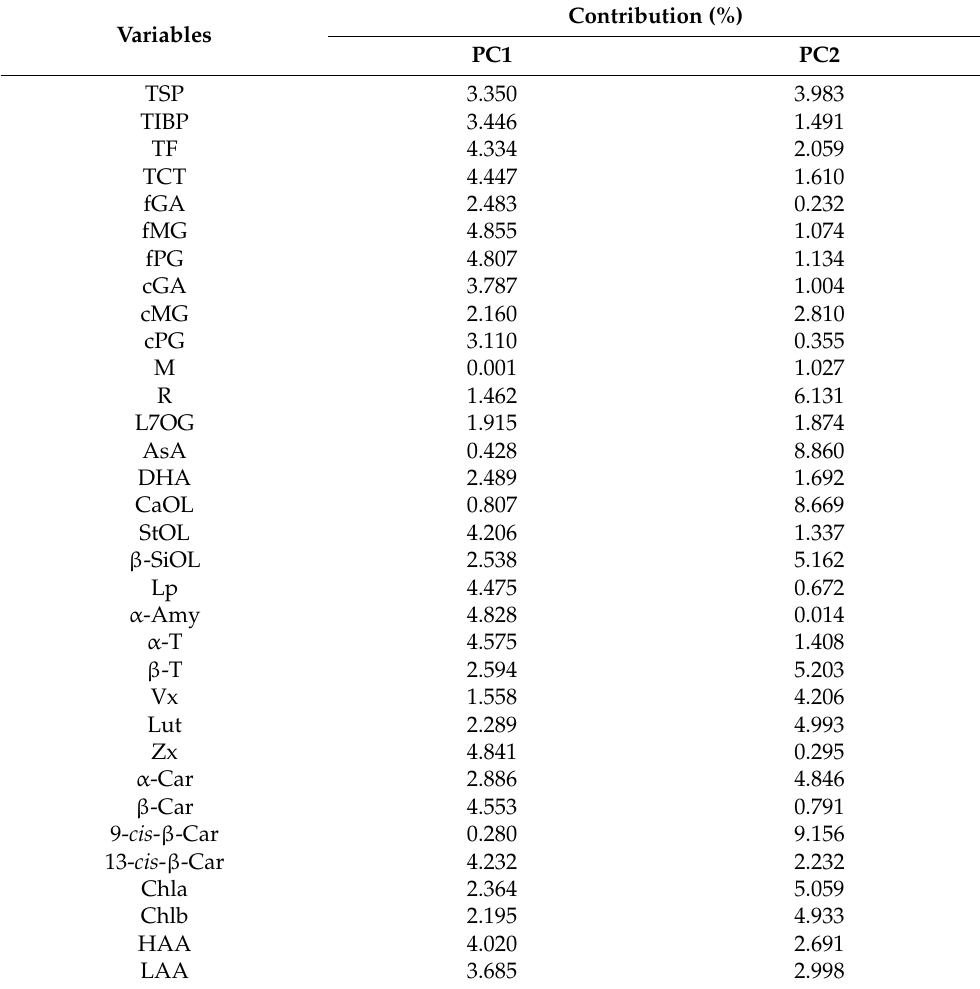
Table 5. Variables participating in the construction of the factorial axes and their relative contribu- tion (%) to PCA